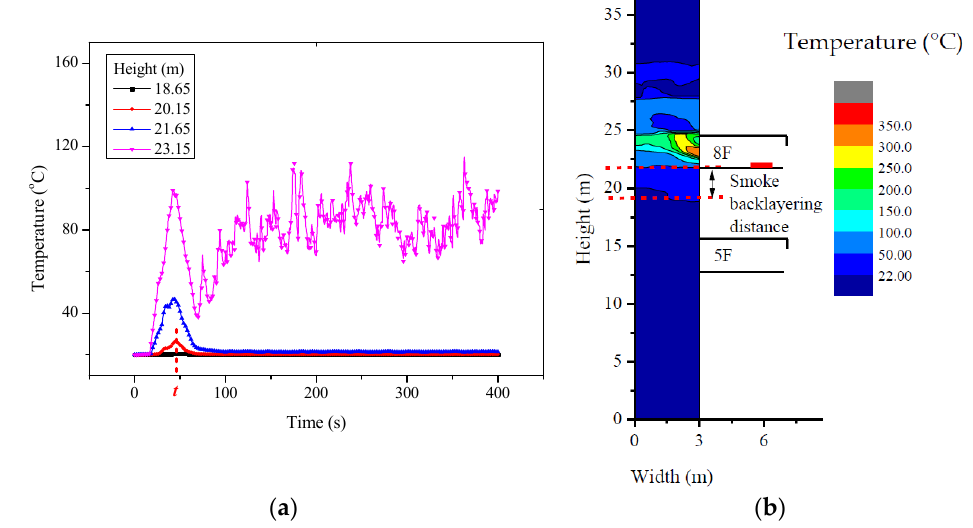
Figure 12. Method to determine the smoke back-layering distance. ( a ) Time history of the tempera- tures. ( b ) Temperature field at 44 s. Table 2. Smoke behaviors in all cases.